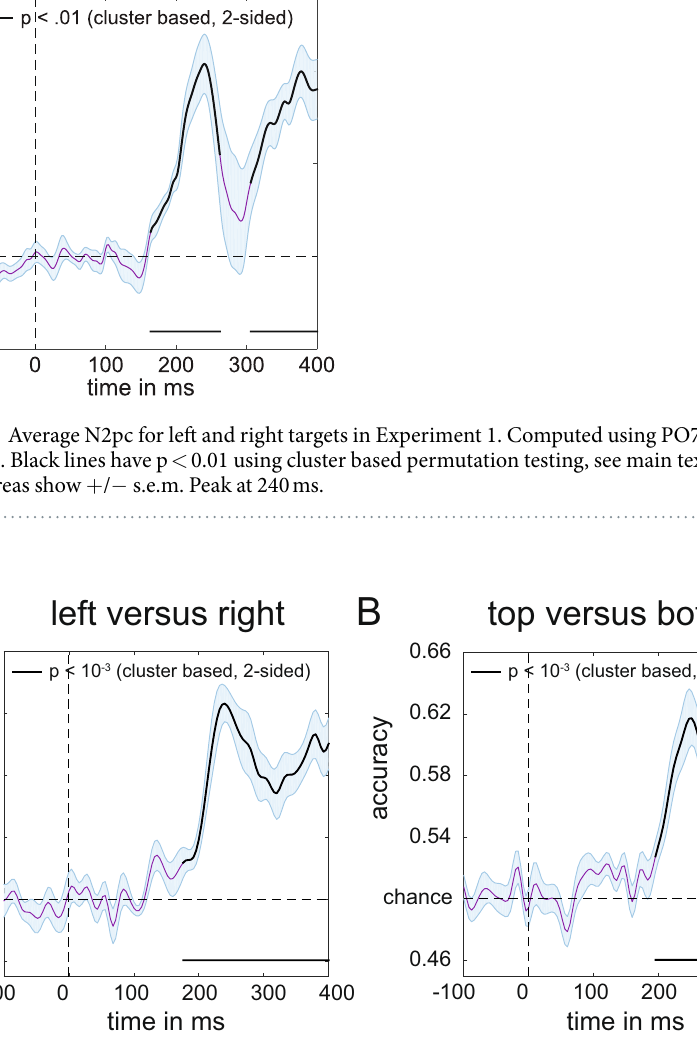
Figure 4. Classification accuracy of target position over time in Experiment 1. ( A ) Classification accuracy for left versus right targets. ( B ) Classification accuracy for top versus bottom targets. Black lines have p < 10 − 3 using cluster based permutation testing. Shaded areas are + / − s.e.m. Peaks respectively at 244 ms (left-right) and 248 ms (top-bottom). Note the similar temporal evolution between N2pc (Fig. 3) and classification accuracy